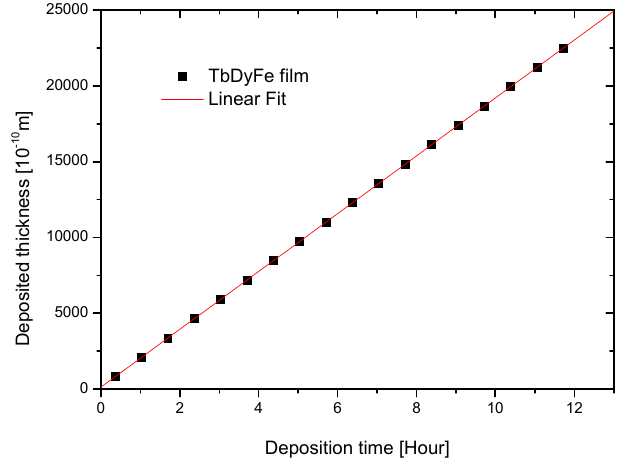
Figure 5. Converted thickness results with deposition time from Equation